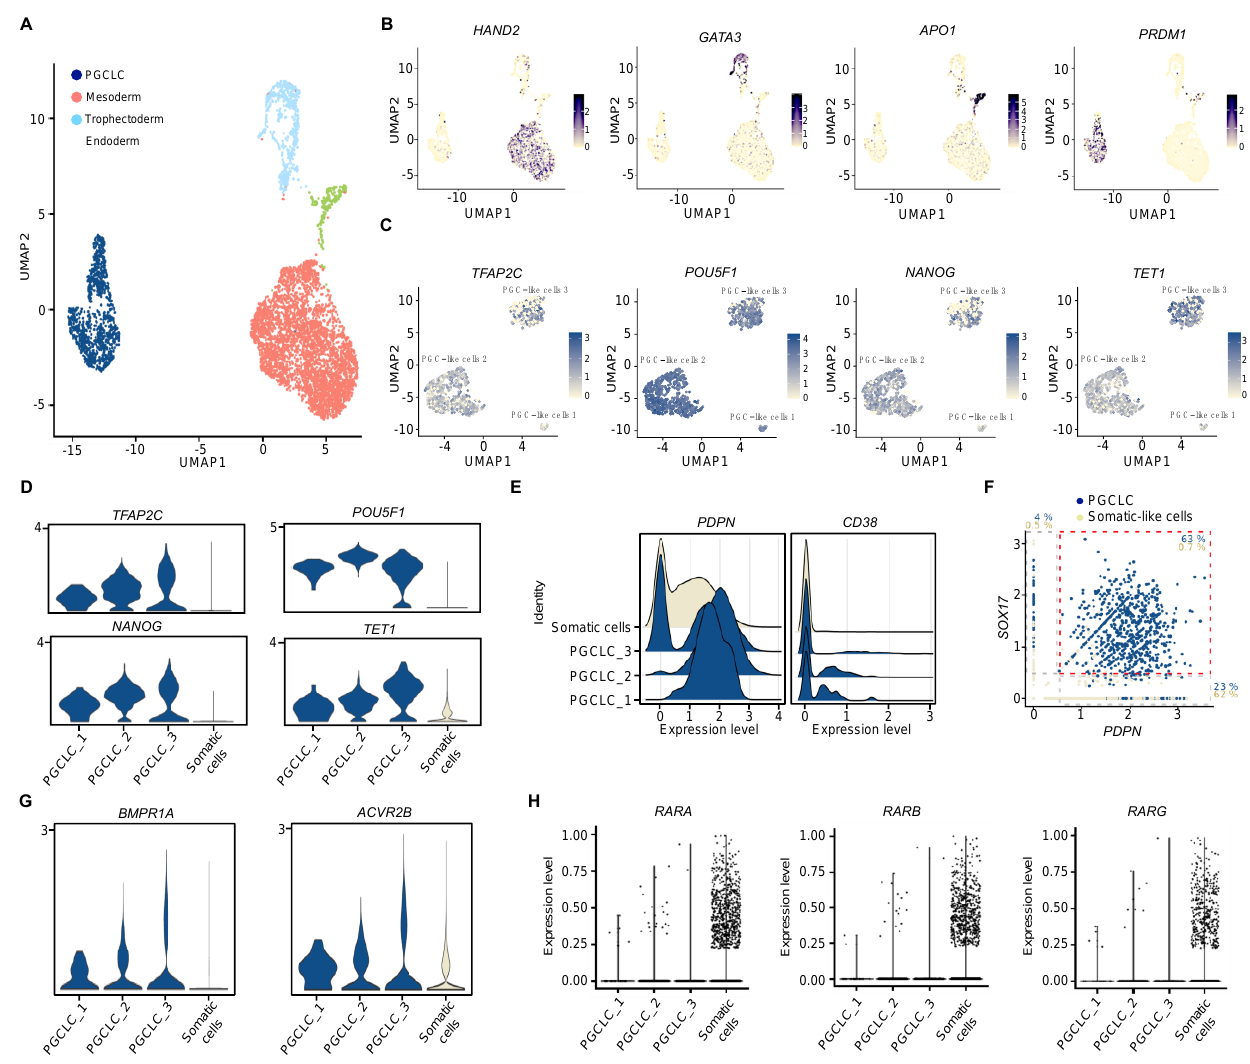
Figure 2. Transcriptional characterization of day 4 EB PGC-LC using scRNA-Seq. ( A ) Two-dimensional UMAP (Uniform Manifold Approximation and Projection) plot of the 5421 cells from two pools of day 4 EB. Cell clusters are colored according to the cell identity (mesoderm, endoderm, trophectoderm or PGC-LC lineages). ( B ) Projection of the expression level of HAND2 (mesoderm), GATA3 (trophectoderm), APO1 (endoderm) and PRDM1 (PGC). ( C ) Projection of the expression level of the PGC ( TFAP2C , NANOG , and POU5F1 ) and the epigenetic ( TET1 ) marker genes in the identified three sub-clusters of PGC-LCs. ( D ) Violin plots showing the expression of TFAP2C , NANOG , POU5F1 and TET1 genes in day-4 PGC-LCs compared to somatic cells. ( E ) Ridge Plot showing the expression levels of PDPN and CD38 genes in comparison to the cell density in different PGC-LC and somatic cell clusters. ( F ) Scatter plot shows the co-expression correlation of PDPN with the SOX17 PGC marker. The percentages of the cell types co-expressing or not SOX17 and PDPN genes are shown either in blue (PGC) or grey (somatic) ( G ) Violin plots for BMP signaling signature in PGC-LCs compared to somatic cells. ( H ) Violin plots showing the gene expression levels of retinoic acid receptors in the indicated conditions.